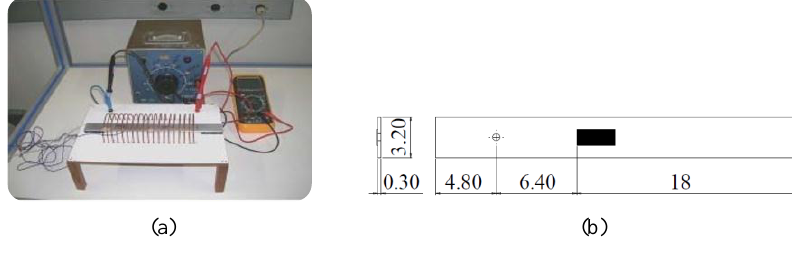
Fig. 5. (a) Experimental arrangement; (b) Geometry of the specimen and position of the PZT